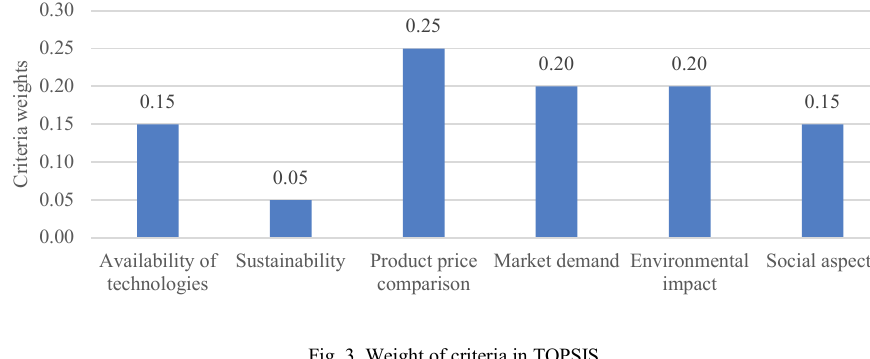
Fig. 3. Weight of criteria in